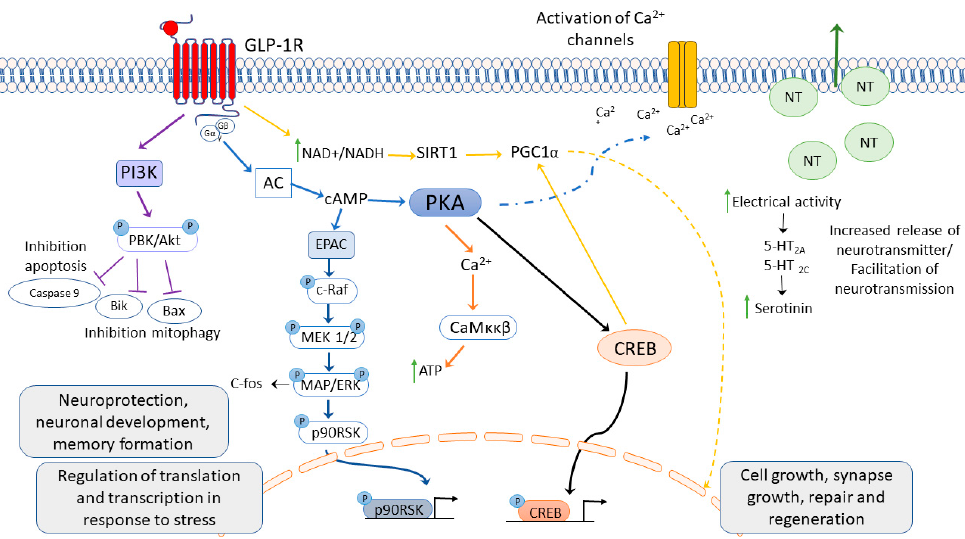
Figure 2. GLP-1 receptor activation induces several second messenger cell signaling pathways.